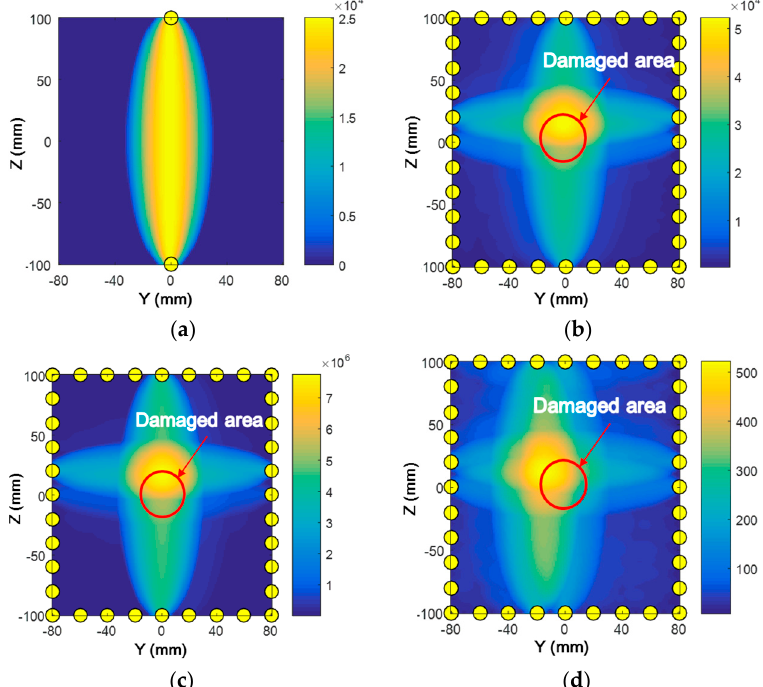
Figure 17. Damage imaging with reconstruction algorithm for the probabilistic inspection of damage (RAPID) in the case of phase matching using various damage indices ( DI s). ( a ) reciprocal of A1 on path five; ( b ) reciprocal of A1 on all paths; ( c ) reciprocal of A2 on all paths; and ( d ) A2/(A1) 2 on all paths.